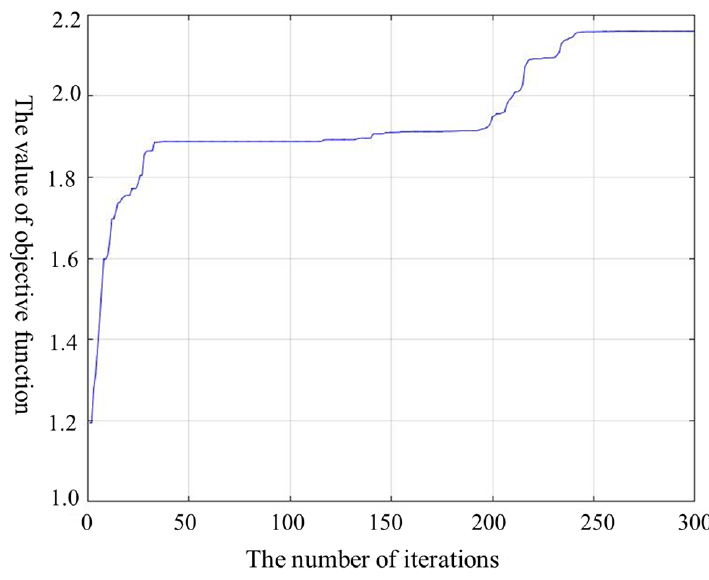
Figure 3. Process of optimizing evaluation indicators. The evaluation indicator data set is stable after 240 iterations (Figure 3). The best pro- jection objective function value is 2.182, and the best projection direction of each indicator is a = (0.00033, 0.13613, 0.10933, 0.0013, 0.3307, 0.0001, 0.2948, 0.3457, 0.2605, 0.4272, 0.3457, 0.0064, 0.1724, 0.1161, 0.3406, 0.3485, 0.0001, 0.2353, 0.0016, 0.2422, 0.0015, 0.0002, 0.0909). The projection value z ( i ) of the 2000–2016 evaluation indicators data set is 2.6121, 2.6125, 2.6116, 2.6125, 2.5111, 2.2826, 1.9002, 1.6039, 1.3174, 0.9666, 1.2011, 1.1154, 1.1154,